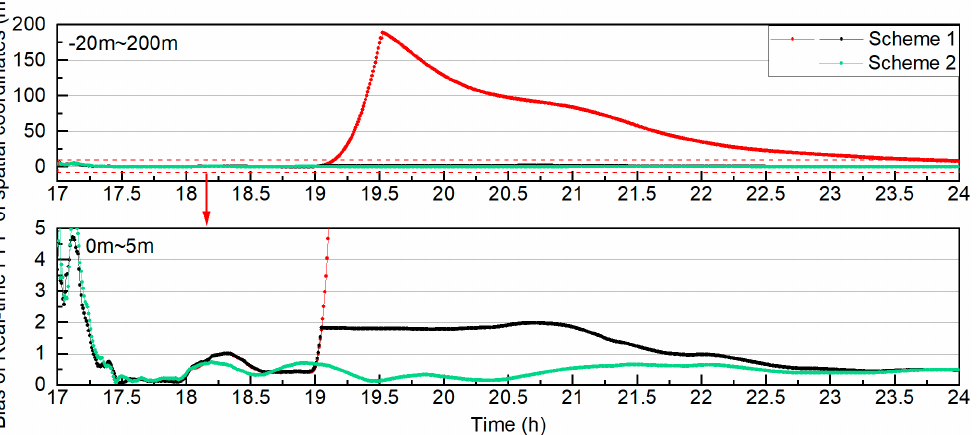
Figure 9. Station distribution and ground track of C07 satellite.